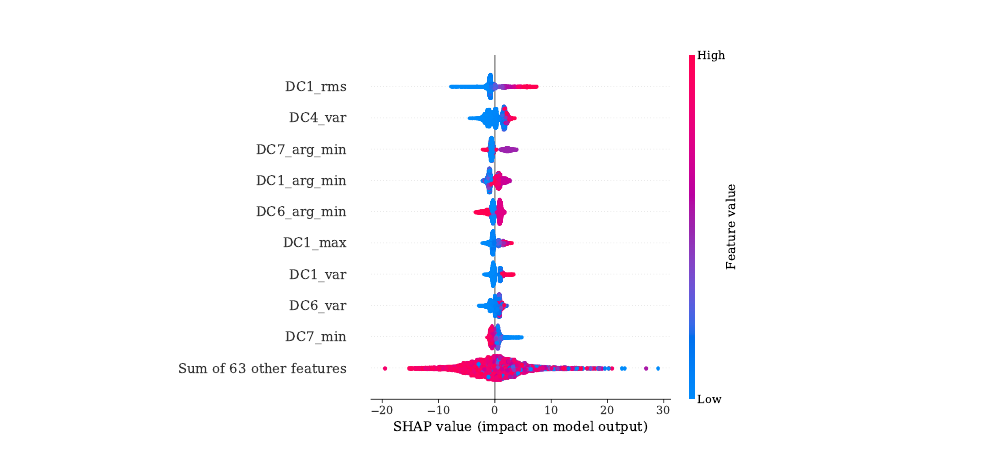
Figure 18. SHAP values summary of PFP regression with regard to training set of engine 2.